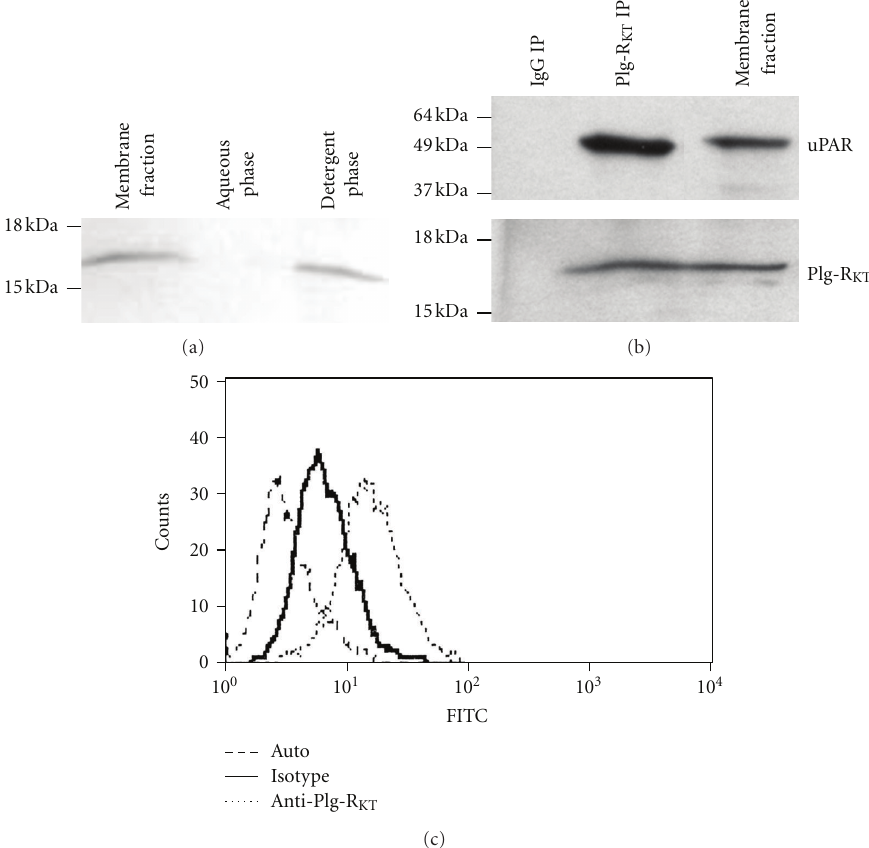
Figure 9: Plg-R KT is an integral plasma membrane cell surface protein. (a) Phase partitioning of Plg-R KT . An immunoreactive band corresponding to the Mr app of Plg-R KT was detected in the detergent phase, but not in the aqueous phase. (b) Coimmunoprecipitation of Plg-R KT with uPAR. (c) FACS analysis of Plg-R KT expression on intact PC12 cells. Viable cells were gated from nonviable cells and histogram plots of viable cells are shown. Dotted tracings: anti-Plg-R KT mAb IgG. Black tracings: isotype control IgG. Dashed tracings: autofluorescence. [25]. ©The American Society for Biochemistry and Molecular